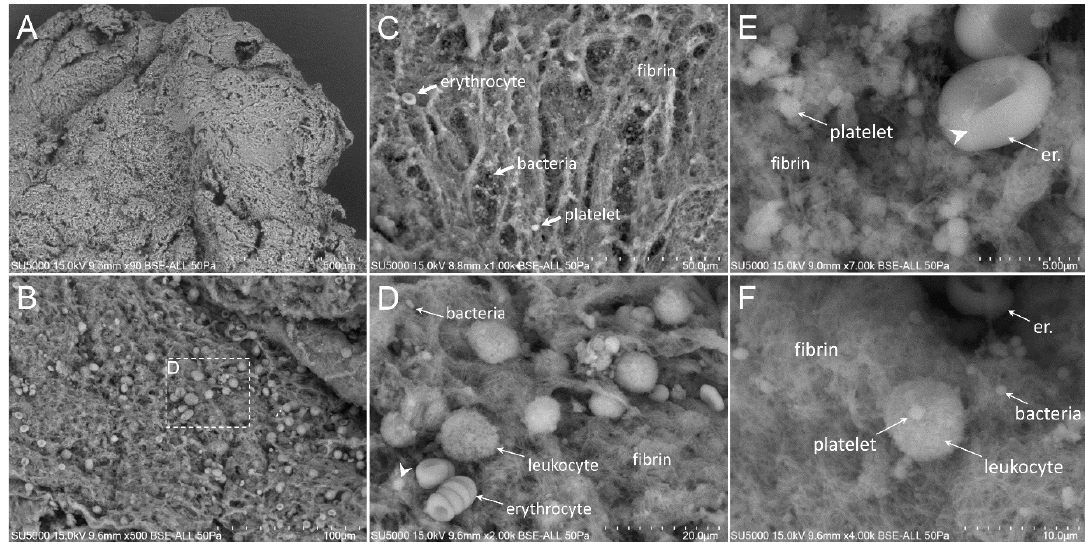
Figure 2. Scanning electron microscopy of S. aureus -infected vegetation. ( A , B ) Low magnification of the vegetation. The vegetation had a filamentous appearance with numerous leukocytes. ( C ) The vegetation is rich in platelets and very thin fibrin fibers, giving the appearance of a fishing net ( D ) Zoom-in on the boxed region in ( B ) showing leukocytes, bacteria and platelets (arrowhead) in a thin fibrinous network. ( E ) Aggregated platelets next to an erythrocyte enwrapped with fibrin fibers (arrowhead). ( F ) Platelets on top of a leukocyte.